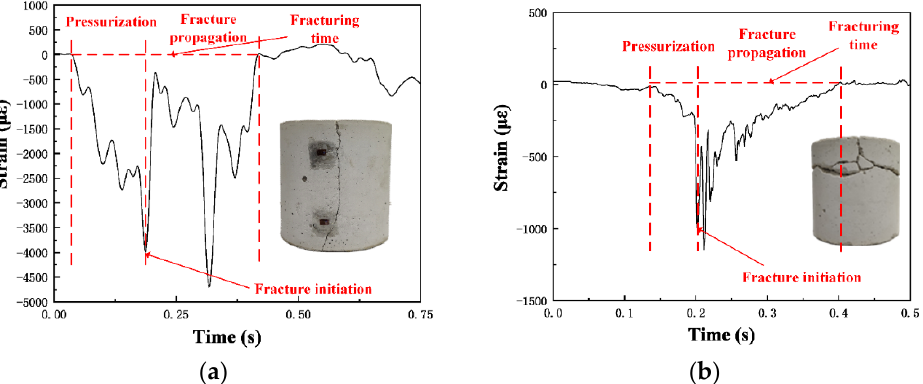
Figure 13. Typical experimental results of strain curve during fracturing. ( a ) Hard rock (specimen A1)